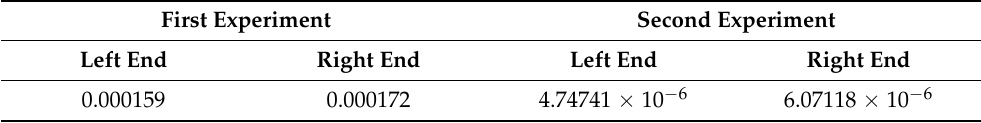
Table 4. Root mean square errors for the first and second experiments at given angular velocities of both the shaft ends in the time interval ∆ t = 0.005 s.